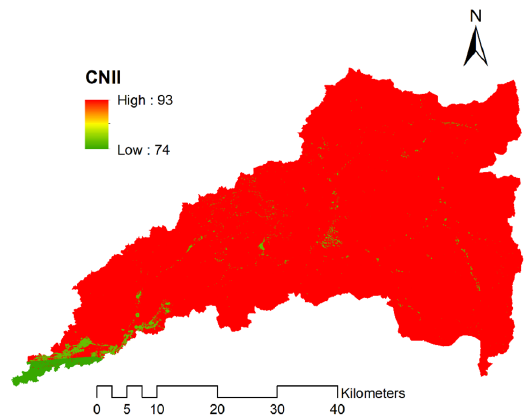
Figure 9. Curve number (CN II ) associated with AMC-II for each cell of the study area.